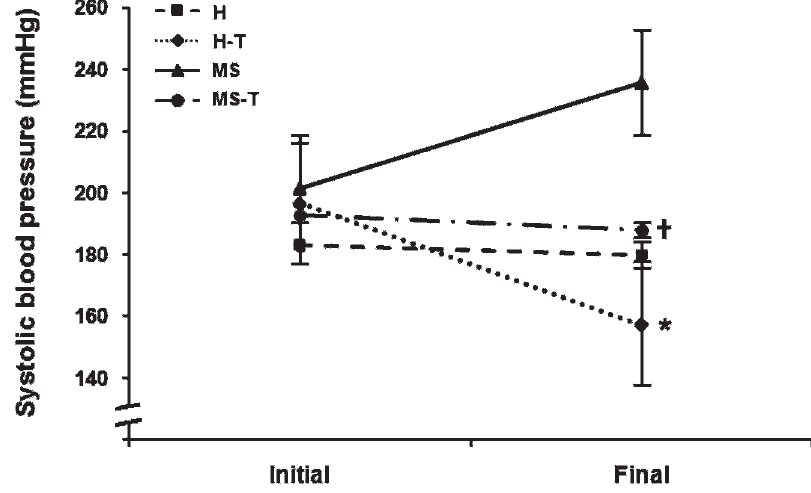
Figure 2 - Effect of 10-week aerobic exercise training on systolic blood pressure. H (n=5): sedentary spontaneously hypertensive rats; H- T (n=5): trained spontaneously hypertensive rats; MS (n=5): sedentary metabolic syndrome rats; MS-T (n=5): trained metabolic syndrome rats. Repeated measures ANOVA: p (group) , 0.001; p (time)=0.344; p (interaction) , 0.001. Bonferroni’s post-hoc test group: * p =0.010 vs. H; { p , 0.001 vs.